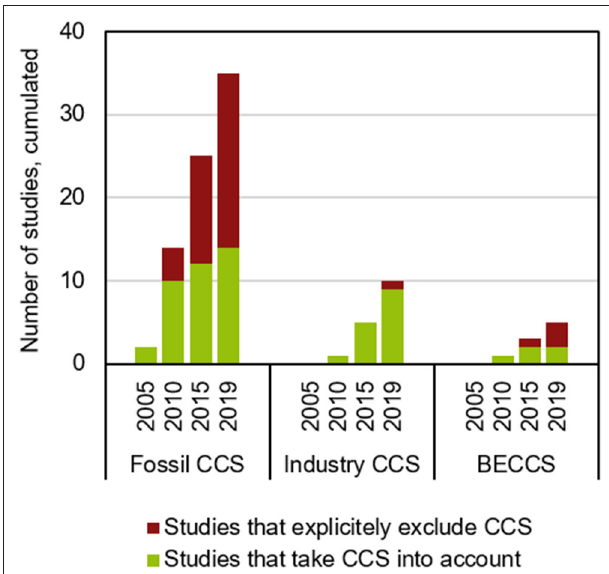
FIGURE 5 | The exclusion of fossil, industrial and biomass-based CCS in German scenario studies over